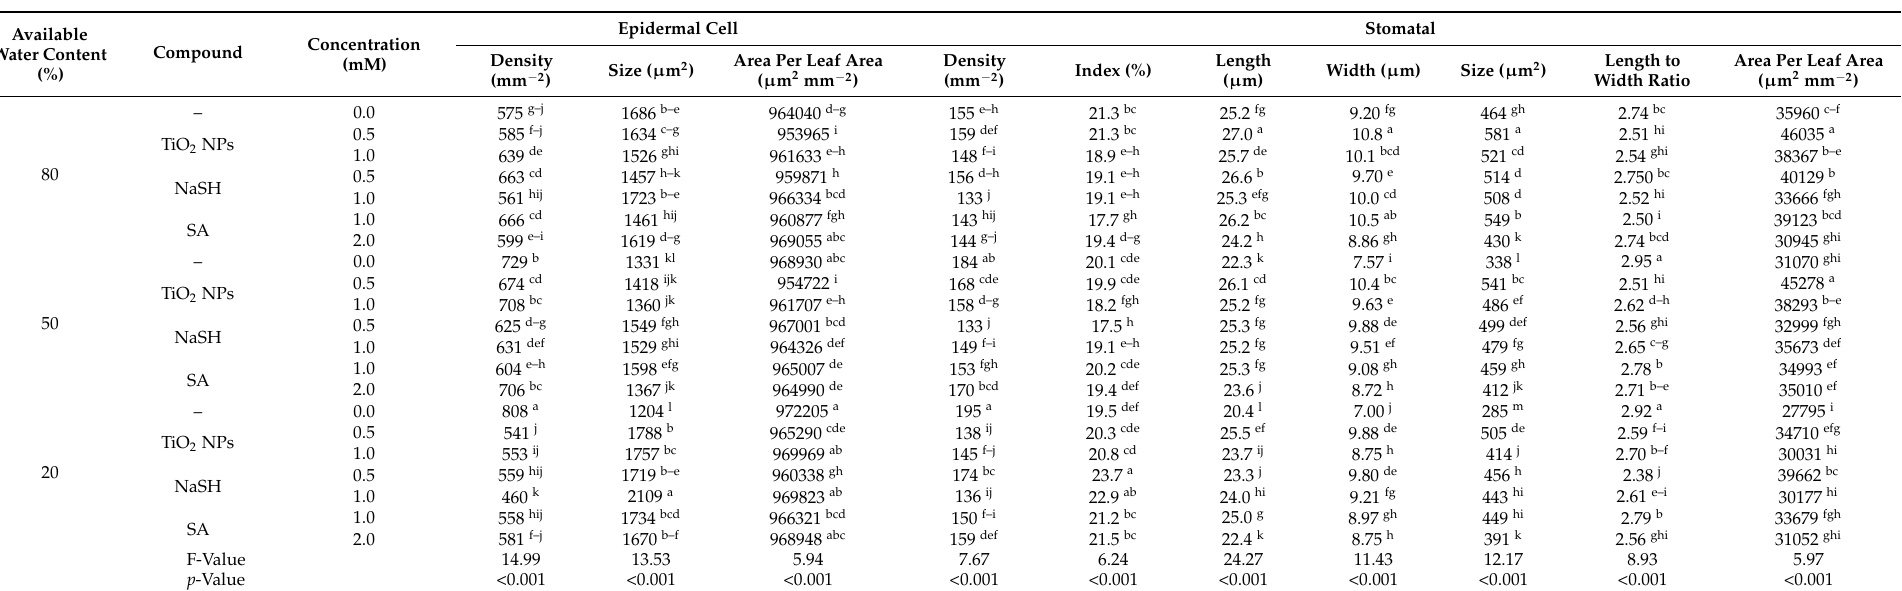
Table 5. Epidermal cell and stomatal anatomical features of periwinkle ‘Pacifica XP Really Red’ plants receiving exogenous application of titanium dioxide nanoparticles (TiO 2 NPs; 0, 0.5 and 1 mM), sodium hydrosulfide (NaSH; 0.5 and 1 mM), or salicylic acid (SA; 1 and 2 mM) under different watering levels (80, 50